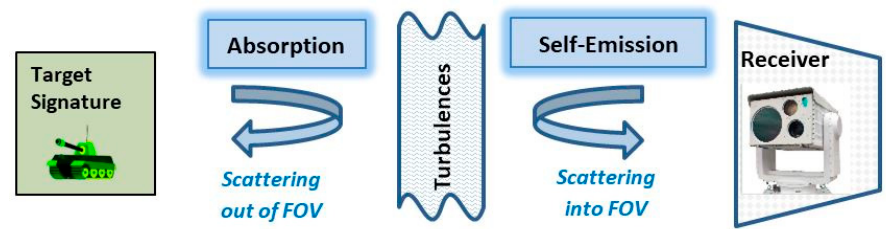
Figure 6. Atmospheric processes influencing attenuation coefficient and thermal imager range.